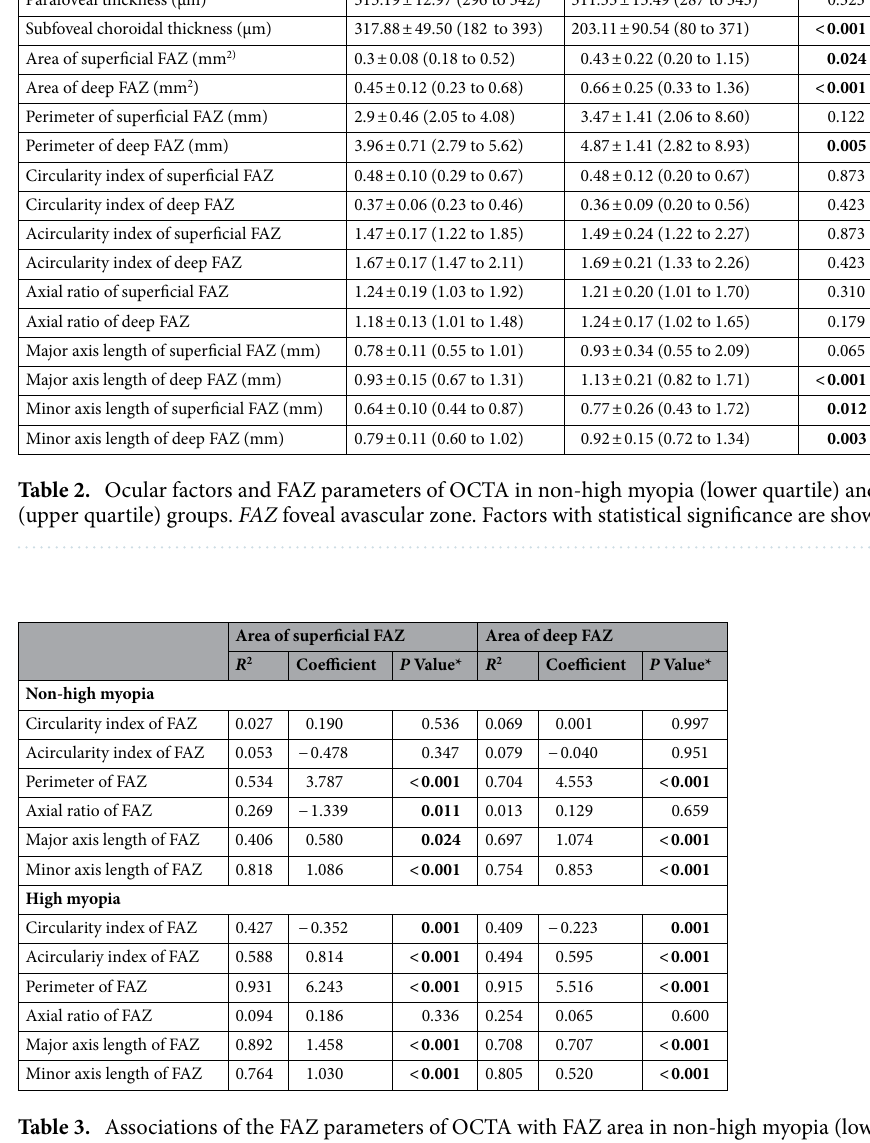
Table 3. Associations of the FAZ parameters of OCTA with FAZ area in non-high myopia (lower quartile) and high myopia (upper quartile) groups. FAZ foveal avascular zone. * P value adjusted for age and sex. Factors with statistical significance are shown in